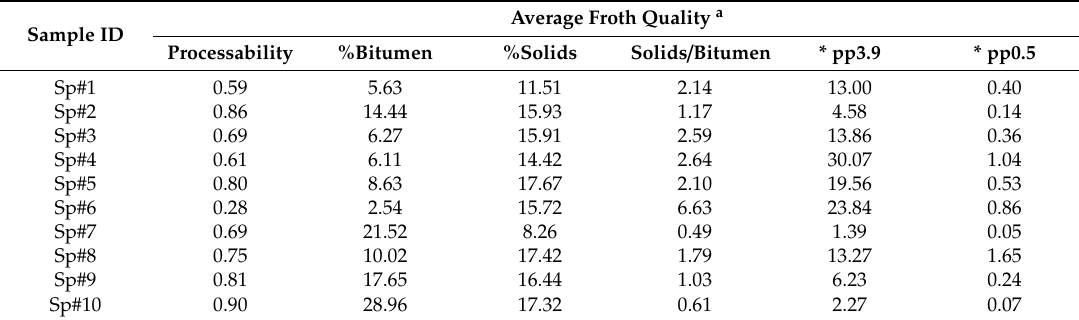
Table 2. Ore processability and froth characteristics of the first sample